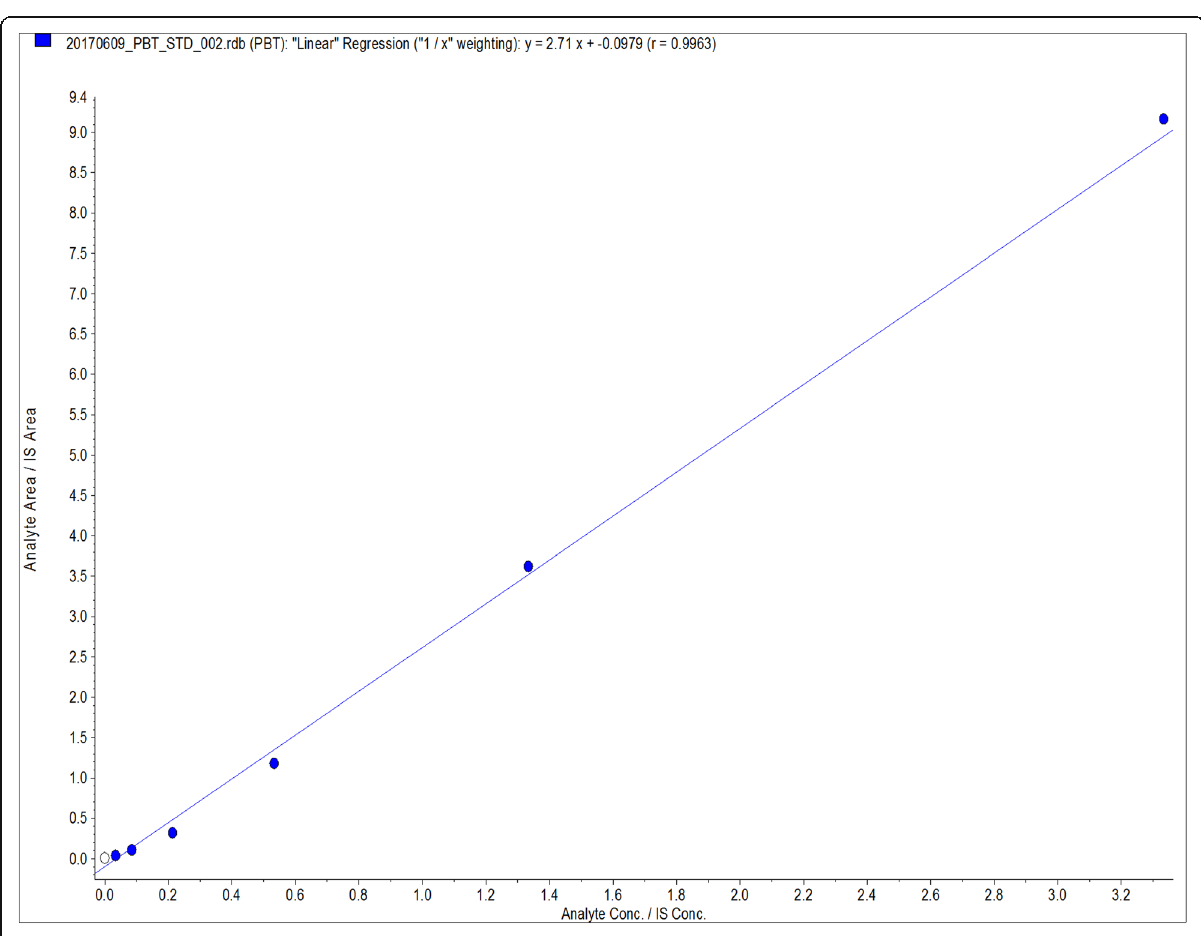
Fig. 6 Standard curve for P-bi-TAT with IS by positive LC-MS/MS